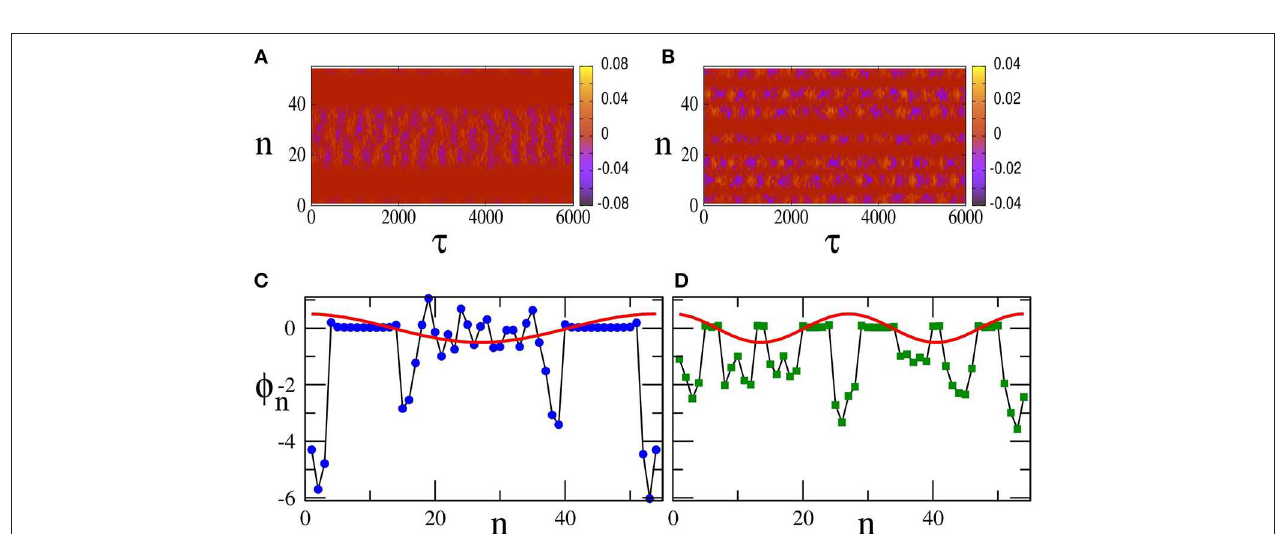
FIGURE 7 | (A) The magnitude of the synchronization parameter averaged over the driving period, (cid:127) 1.01, N 54, φ dc 0, and φ ac 0.02 (black), φ ac 0.04 (red), φ ac 0.06 (green), φ ac = = = = = = magnitude of the synchronization parameter averaged over the steady-state integration time τ sst , parameters are as in (A) . (C) The flux profile φ n for φ ac 0.02 and the other parameters as in (A) . (D) The flux profile φ n for φ ac = as in (A) .